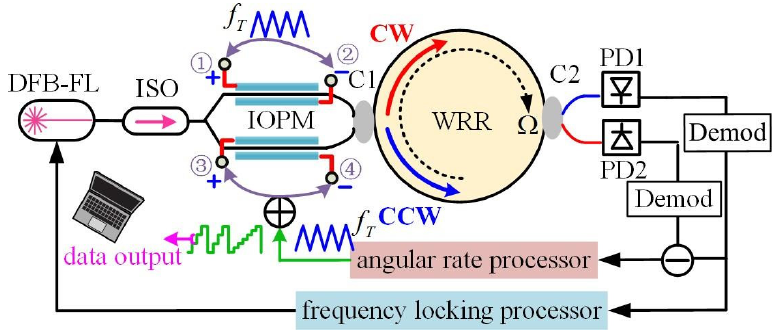
Figure 20. The schematic diagram of RIOG with the double closed-loop control system. 1 and 2 are the upper arm of the IOPM, 3 and 4 are the bottom arm of the IOPM. Reprinted with permission from ref. [91]. Copyright 2018 The Optical